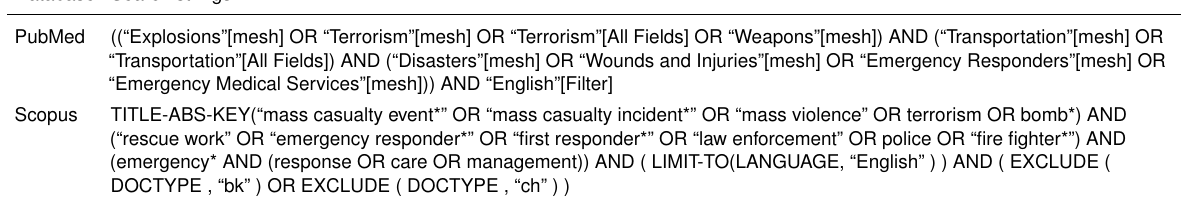
Table 1. Database